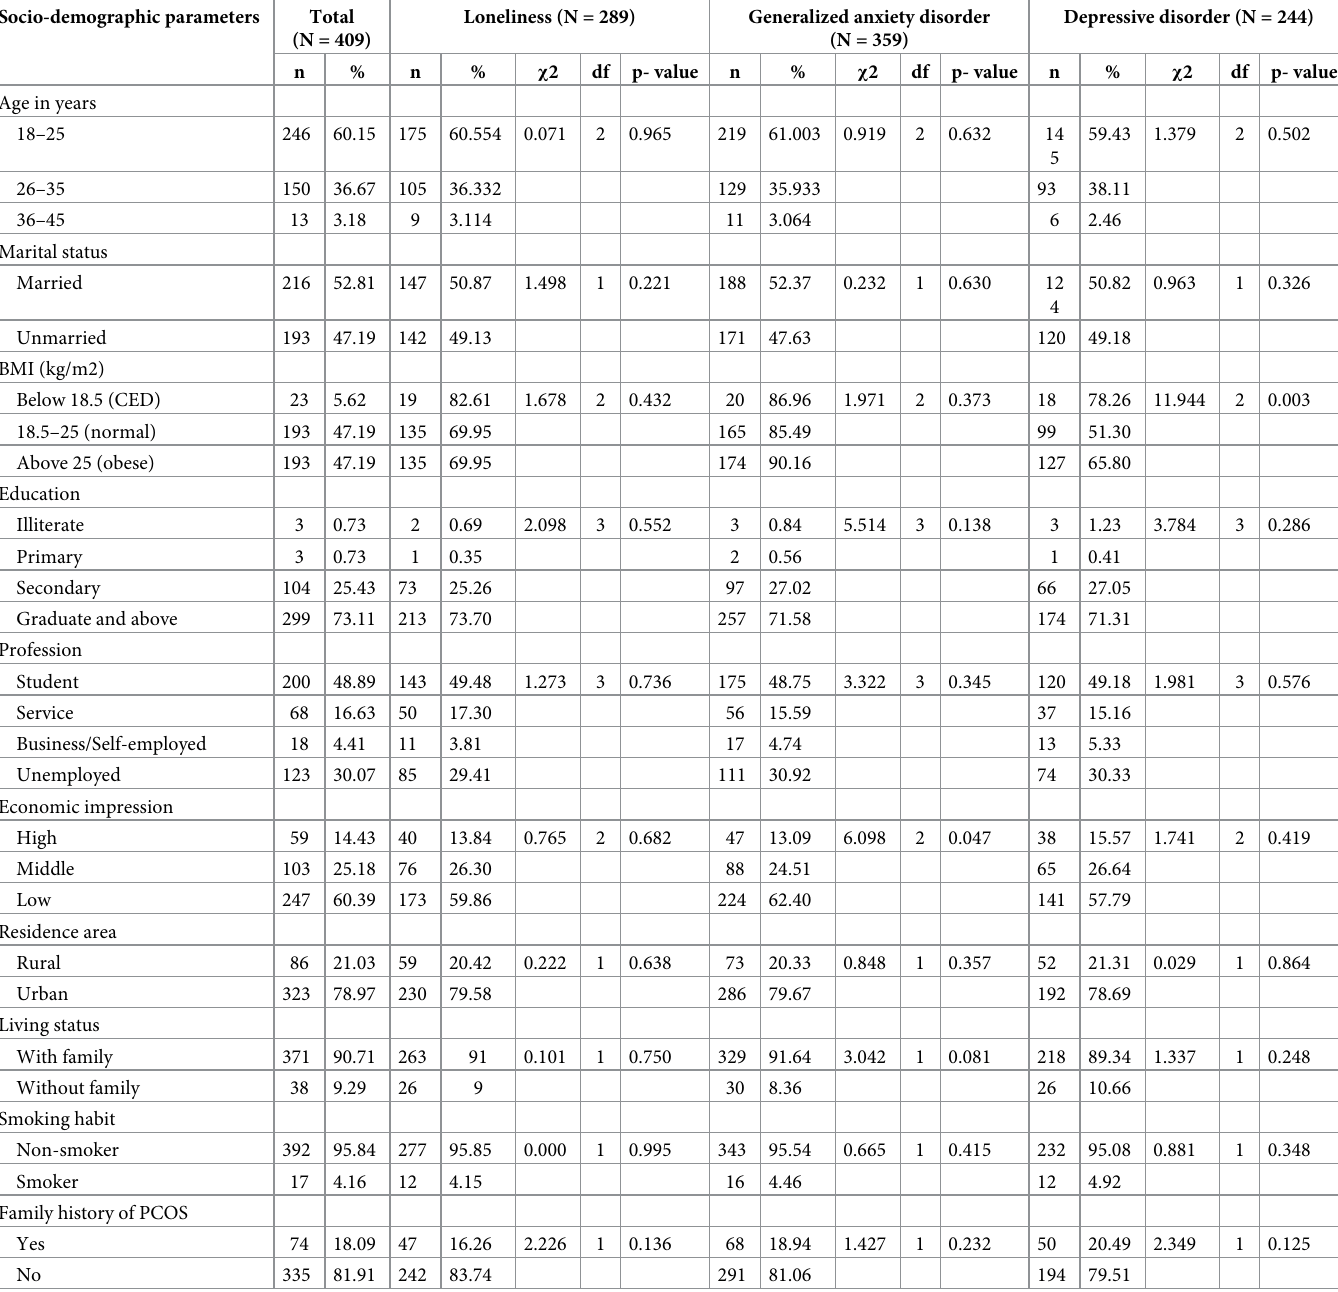
Table 1. Distribution of socio-demographic variables and their association with mental health problems among the patients suffering from the polycystic ovarian syndrome. Socio-demographic parameters Total Loneliness (N = 289) Generalized anxiety disorder Depressive disorder (N = (N = 409) (N = 359)